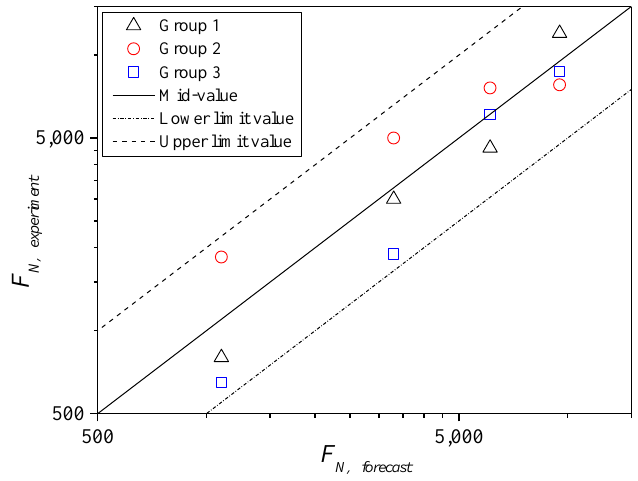
Figure 14. Distribution of F N for fiber asphalt mixture. The mean values of the test results of F N , namely, the median values of the dispersion band of twice safety factor, which was considered the instability life of the specimen. Moreover, the predicted F N of the fiber asphalt mixture under the same stress state are shown in Figure 15. The figure shows that when the shear stress ratio τ n / τ 0 of the fiber asphalt mixture is the same, the predicted F N deviate from that of the TDCT to some degree. However, the tested F N is evenly distributed on both sides of the predicted curve; thus, the prediction model can be verified.